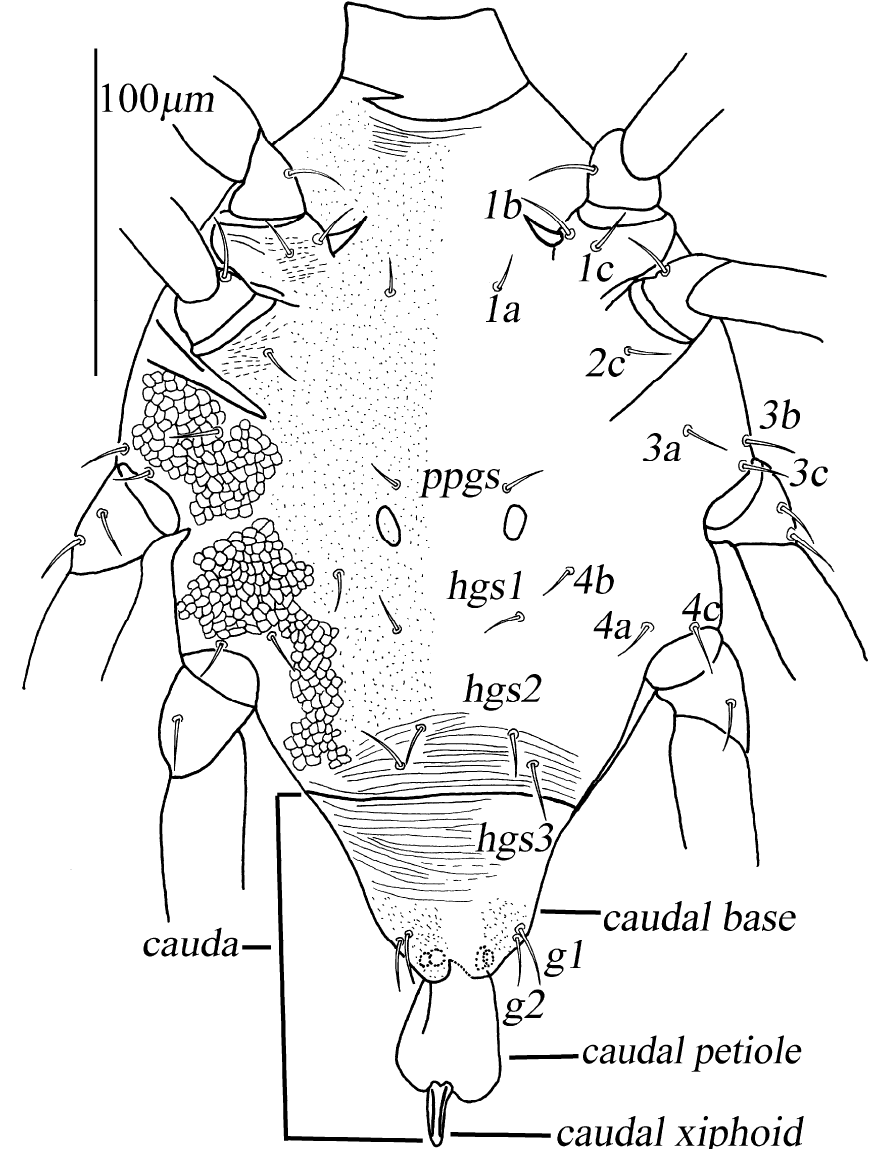
Figure 17. Brevicaudus trapezoides sp. nov. (male). Ventral idiosoma. Scale bar = 100 µ m.